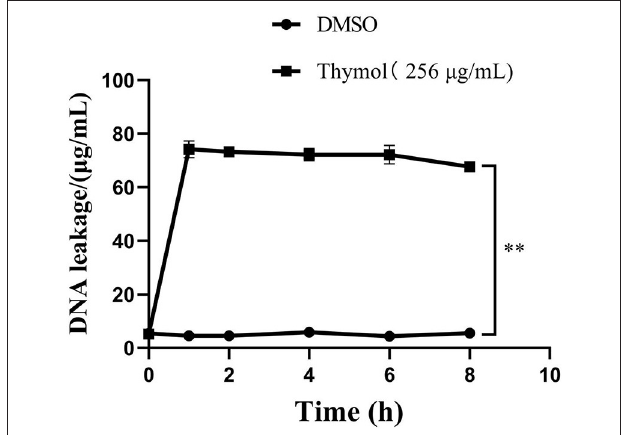
FIGURE 6 | Thymol increased the leakage of S. iniae DNA. ** p < 0.01 when compared with control group.